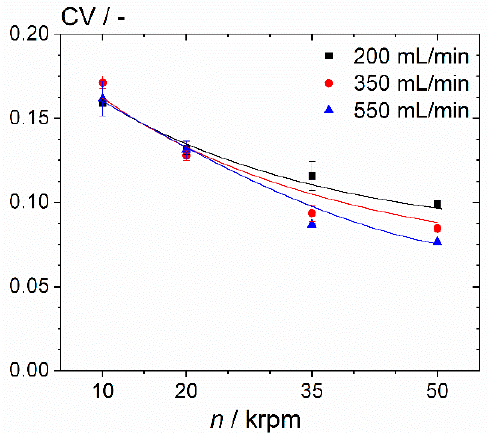
Figure 7. Coefficient of variation calculated from time-dependent spray area vs. nominal rotational speed n for different volumetric flow rates (cid:1848)(cid:4662) .